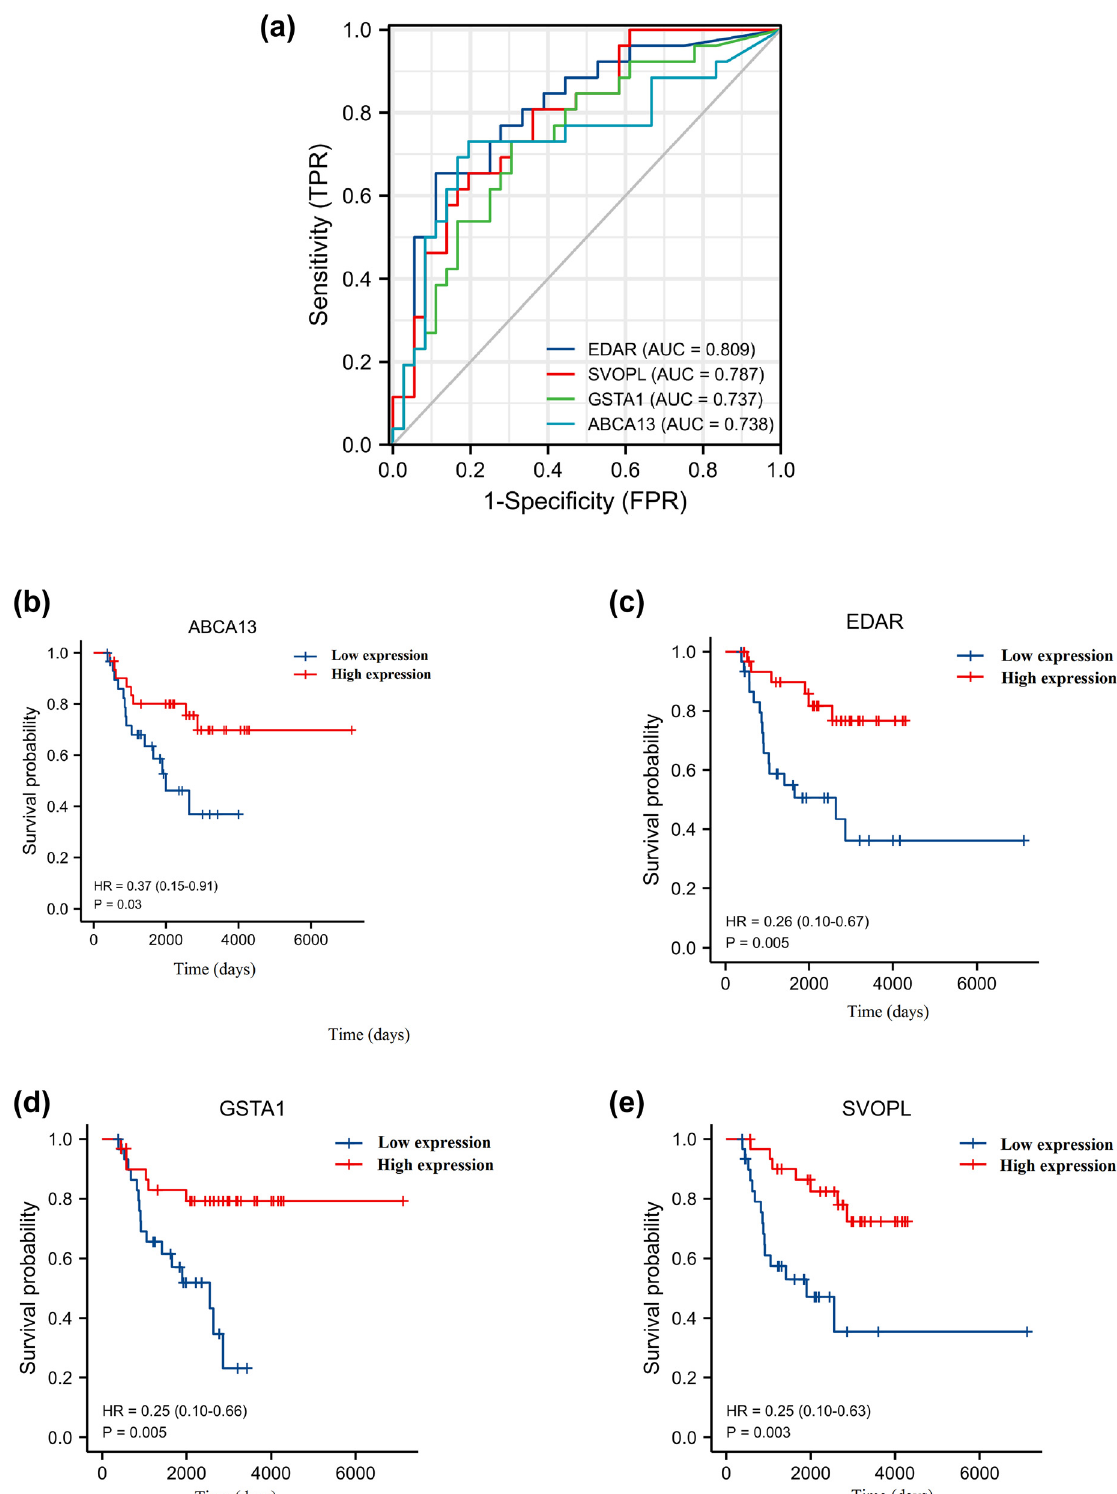
Figure 3: ROC and Kaplan – Meier analyses of prognostic biomarkers of patients with breast cancer undergoing chemoradiotherapy. ( a ) ROC curves were applied to assess the predictive ability of the hub genes in breast cancer. Kaplan – Meier OS analysis of ( b ) ABCA13, ( c ) EDAR, ( d ) GSTA1, and ( e ) SVOPL in breast